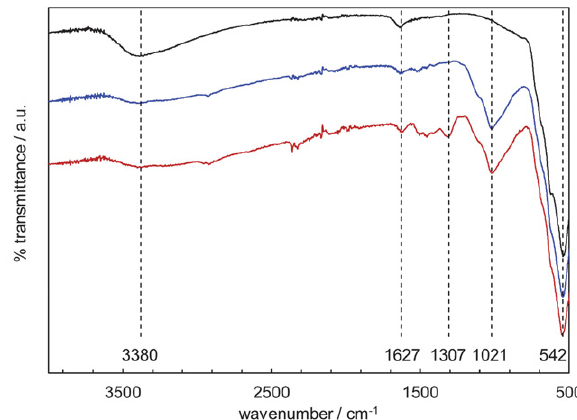
Figure 3: ATR-FTIR spectra of γ-Fe 2 O 3 -NH 4 OH (top curve, black), γ-Fe 2 O 3 -NH 4 OH@SiO 2 (APTMS) (middle curve, blue) and Nd 3+ / γ-Fe 2 O 3 -NH 4 OH@SiO 2 (APTMS) (bottom curve,